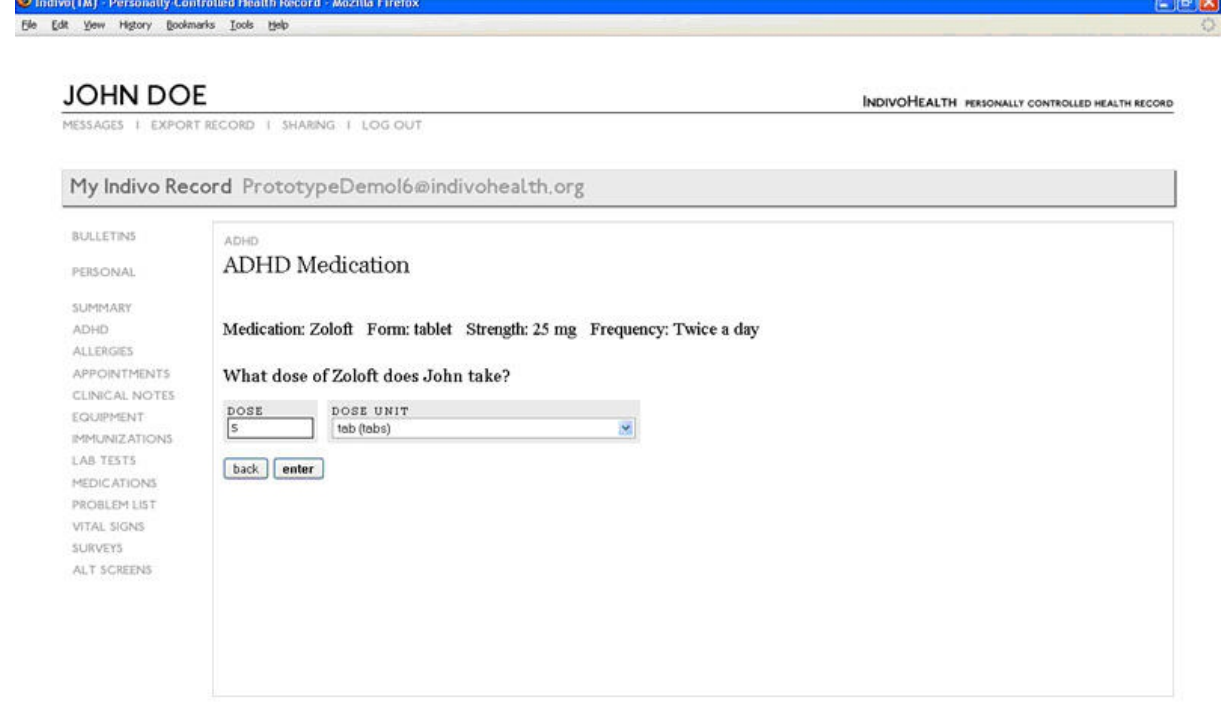
Figure 3. Screenshot from the medication module of the initial prototype of the ADHD personal health application tested following a think aloud